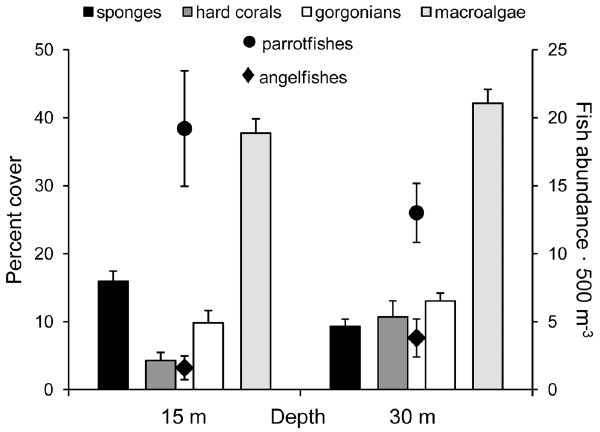
Figure 3. Percentage benthic cover of sponges, reef-building corals, gorgonian corals and macroalgae and abundance of the dominant sponge-eating fishes at 15 m and 30 m depth on Conch Reef, Florida. Benthic cover is shown in bars (y-axis on left), fish abundance in dots and diamonds (y-axis on right). Error bars are standard